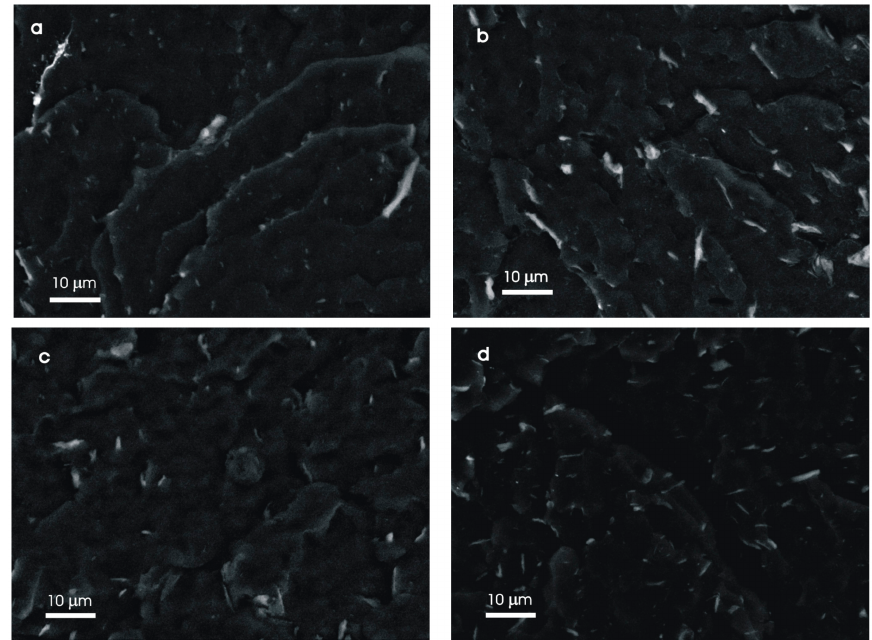
Figure 8. SEM micrographs (backs-scattered electrons) of CNC/LLDPE composites, showing CNC distribution in the LLDPE matrix as a function of CNC concentration and surface modification: ( a ) 2 wt % unmodified CNCs; ( b ) 5 wt % unmodified CNCs; ( c ) 2 wt % CNCs modified with AcAnh; ( d ) 5 wt % CNCs modified with AcAnh.